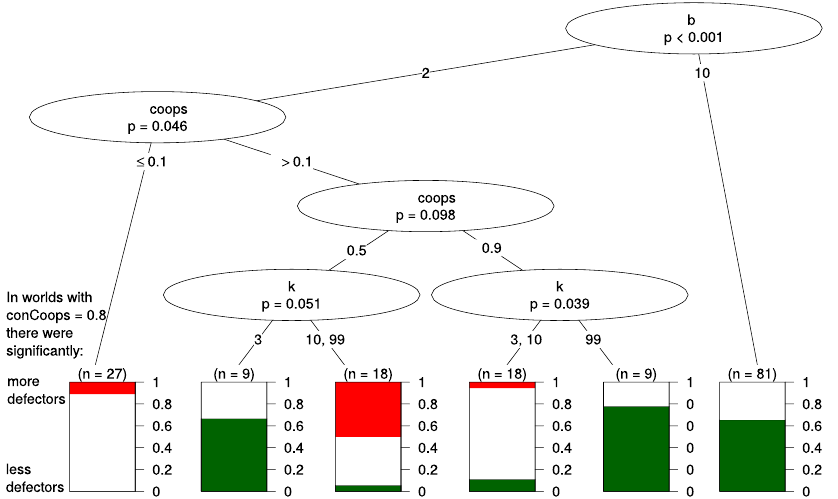
Figure 4. Results of regression tree analysis. The tree predicts whether worlds with conCoops = 0.8 lead to more or less defectors than when conCoops =